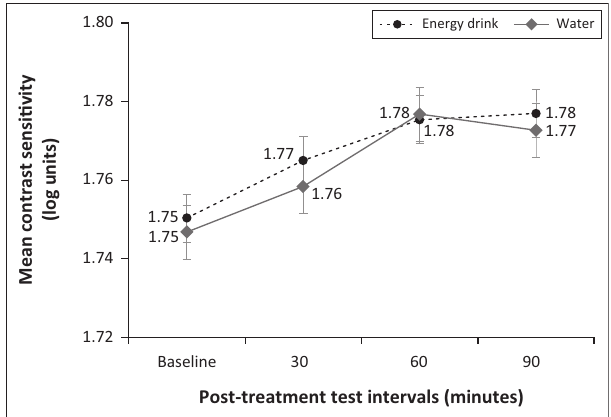
FIGURE 2: Time courses of contrast sensitivity at baseline and at 30 min, 60 min and 90 min post-treatment with 250 mL energy drink or TABLE 2 : Multiple regression analysis: Body mass index, age and tear break up time versus change in near contrast sensitivity post-treatment. Model Unstandardised coefficients